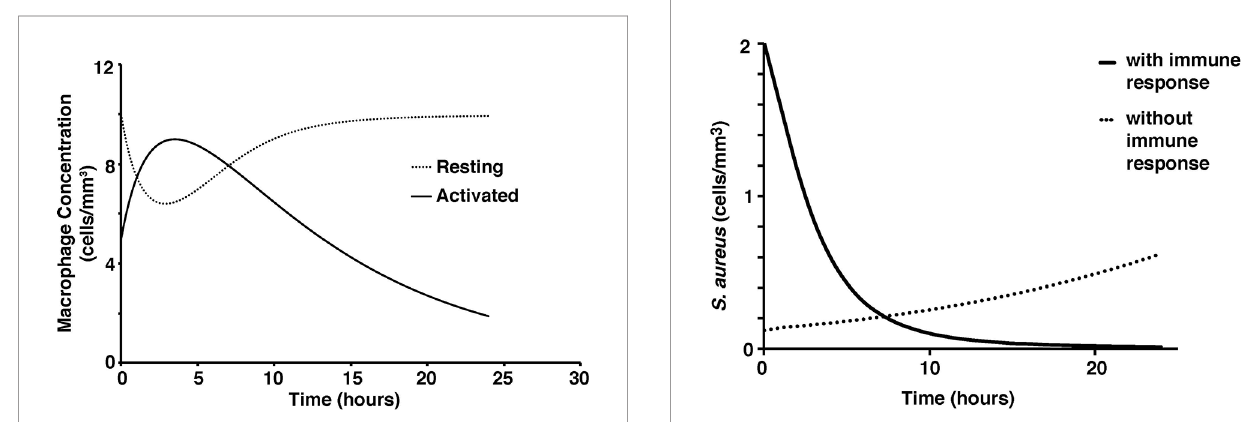
FIGURE 2 | Concentration of activated and resting macrophages over a 24- hour